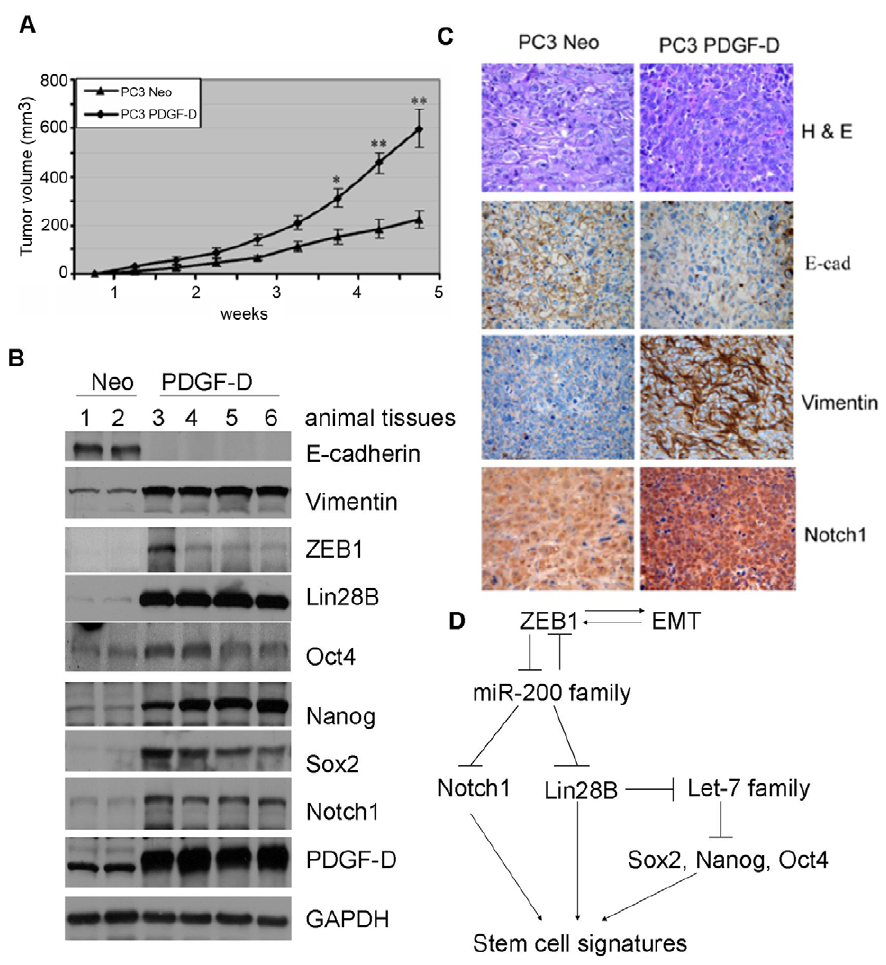
Figure 8. The cells with EMT phenotype promoted tumor growth. (A) Tumor growth curve showing that over-expression of PDGF-D could promote tumor growth in SCID mice much faster than PC3 Neo cells. (B) Western blot analysis of tumor lysates showing the expression of EMT and stem cell makers. (C) H&E evaluation of the tumors from both the groups showed high grade carcinoma associated with tumor apoptosis and necrosis. The results from the immunostaining showed much intense staining for vimentin and Notch1 and less intense staining for E-cadherin. (D) Regulatory model showing mechanistic link between EMT and stem cells: EMT induced by different factors characterized by increased expression of ZEB1, which causes loss of miR-200 family. Loss of miR-200b and miR-200c lead to increased ZEB1, Notch1 and Lin28B expression, resulting in decreased expression of let-7. Downregulation of let-7 leads to the up-regulation of Sox2, Nanog and Oct4, which together with Notch1 and Lin28B contribute to stem cell signatures. (*, p , 0.05, **, p , 0.01 compared to PC3 Neo, E-cad: